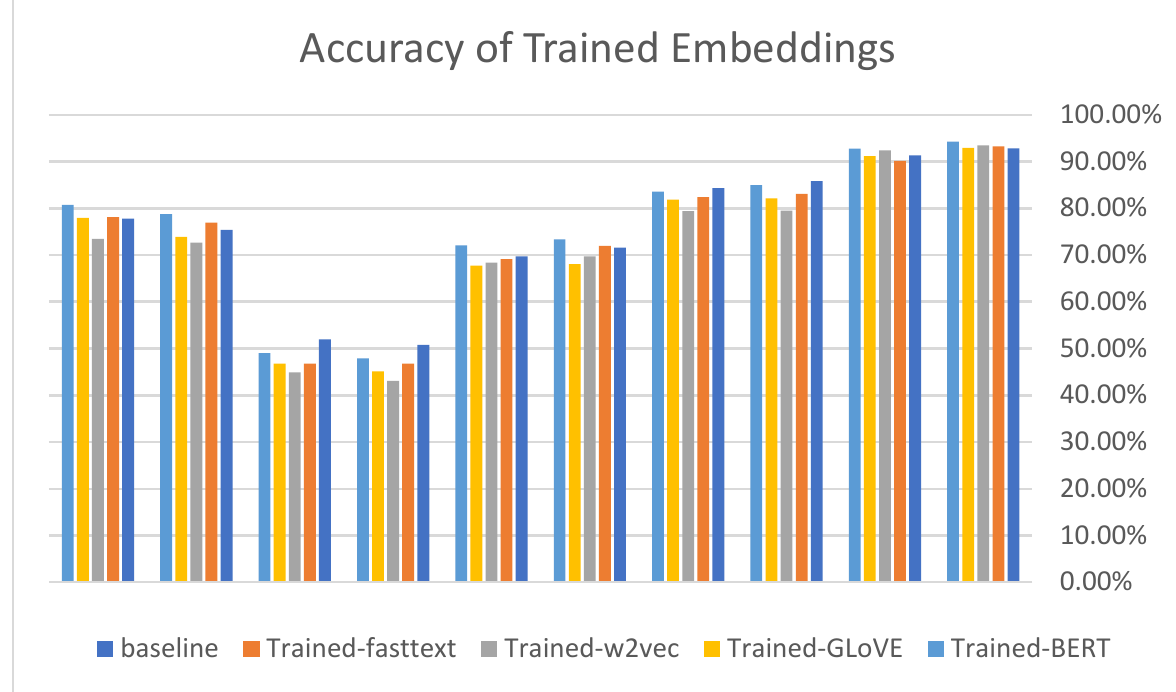
Figure 2. The accuracy of trained embeddings models .